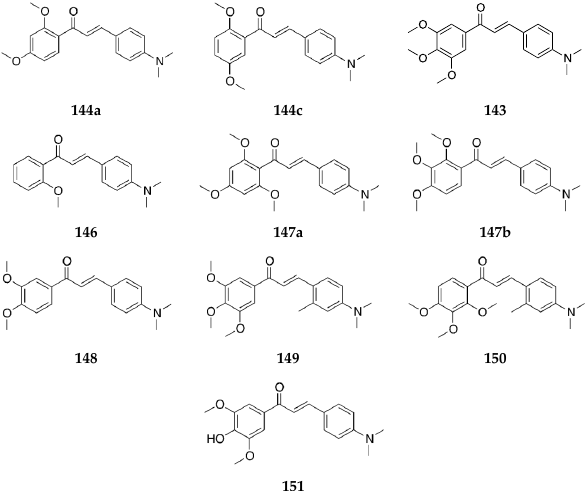
Figure 55. Chemical structure of N,N -dimethyl-4′-aminochalcone derivatives with methoxy substitutions on ring A. In addition to those in Figure 55, Edwards et al. [61] also reported several N,N -dimethyl-4′- aminochalcones with substitutions on the C=C bond of the chalcone group (Figure 56).